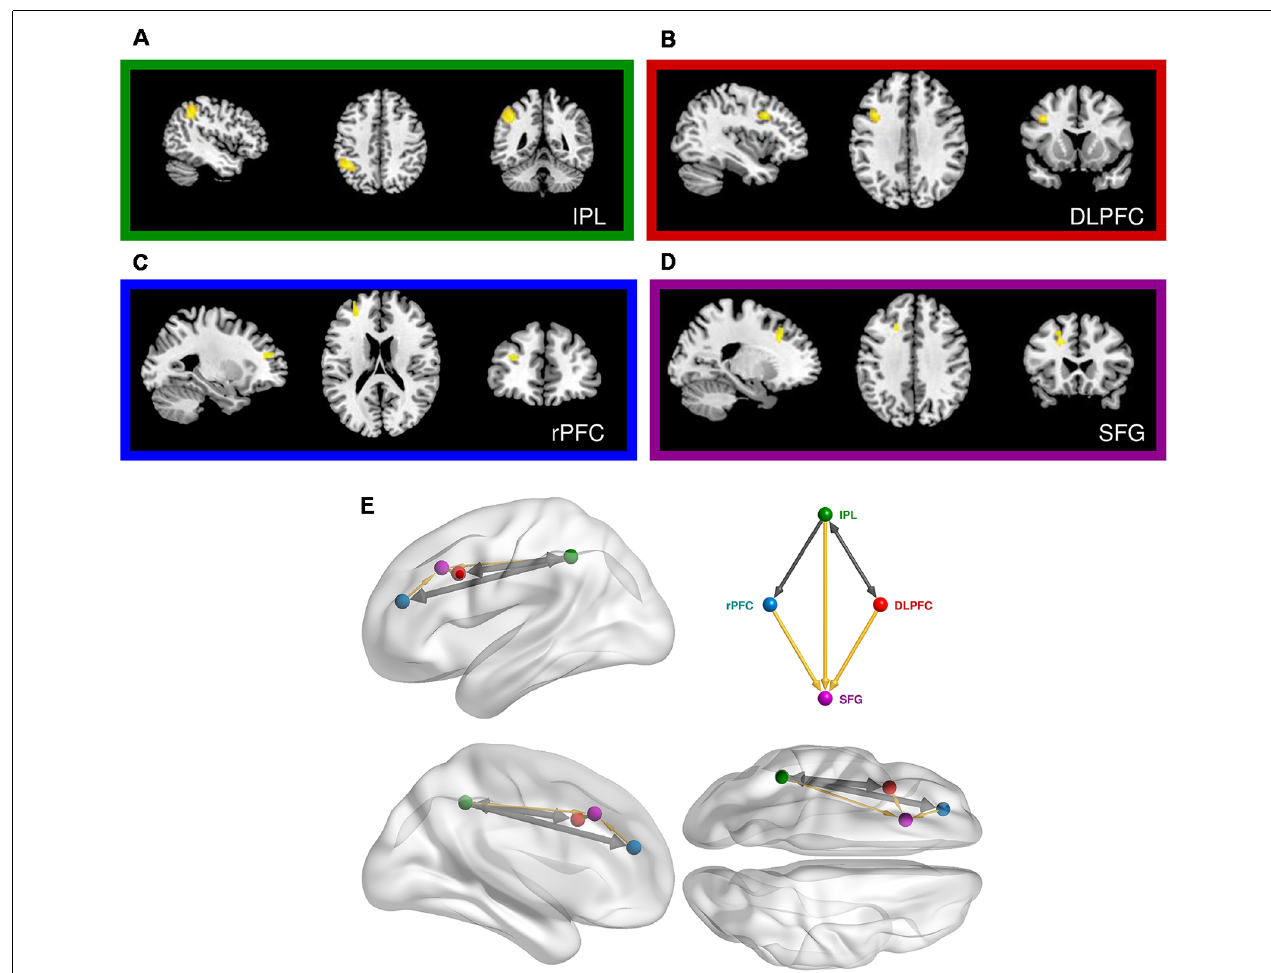
FIGURE 4 | Prefrontal cortical regions engaged in the same-different vibrotactile trials. (A) Main effect of the “Different > Same” contrast in the left inferior parietal lobe (IPL). (B) Main effect of the “Different > Same” contrast in the left dorsolateral prefrontal cortex (DLPFC). (C) Main effect of “Noise-free > Noisy” contrast in the left rostral PFC (rPFC). (D) Interaction of noise and difference in the left superior frontal gyrus (SFG). (E) Relative anatomical location of the corresponding nodes employed in the dynamic causal modeling (DCM), as labeled and colored in the inset. Thick arrows show effective connectivity common to all DCM models. Thin yellow links show connections used in some but not all